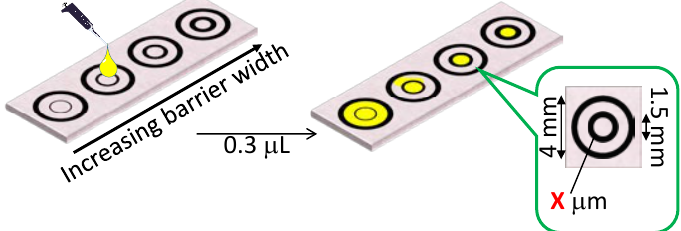
Figure 3. Schematic of the experimental method used to evaluate the minimally required wax barrier width. The indicated dimensions ( x = 200–350 µm) refer to the values set for wax printing and do not represent the actual dimensions obtained after hot lamination. Table 1. Evaluation of minimally required printed wax barrier width (images converted to grayscale and contrast adjusted for improved visibility).